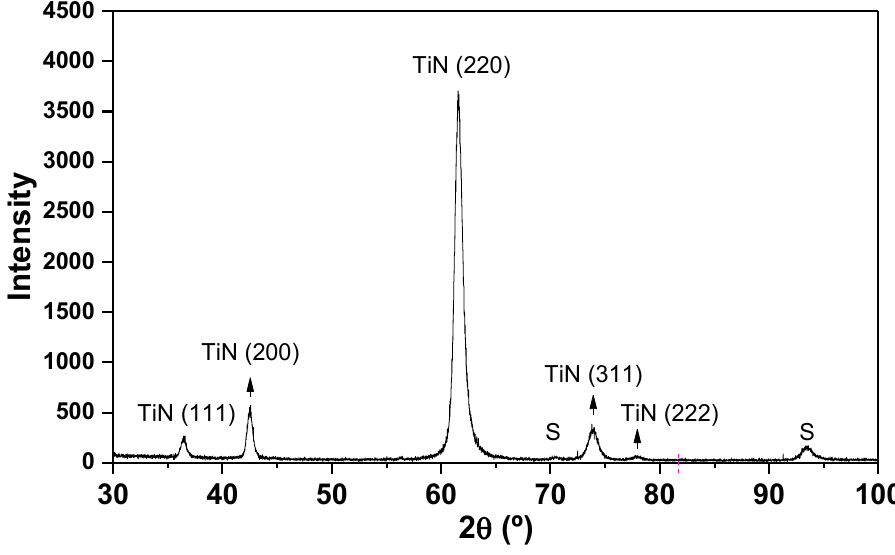
Figure 8. X-ray diffraction pattern of TiN coating.